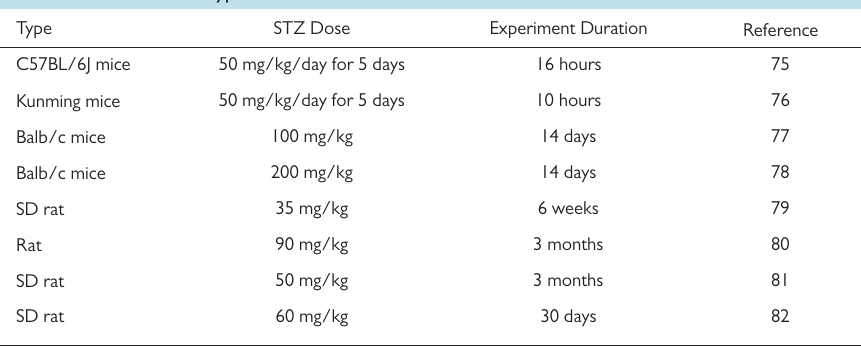
Table 6. STZ-Induced Type 1 Diabetes Model in Rats and